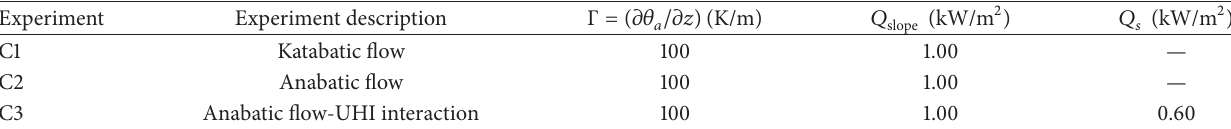
Table 2: Slope flow experimental parameters. Time 𝑡 = 0 corresponds to beginning of image and temperature acquisition; for experiments C1 and C2 heat is provided along the slope from 𝑡 = 20 s; for experiment C3 the UHI heat flux begins at time 𝑡 = 2 s and heat is provided along the slope from 𝑡 = 120 s; in experiments C2 and C3 the bottom is heated from 𝑡 = 2 s from the beginning of the experiments to start and sustain convection. Γ was the vertical component of the temperature gradient; 𝑄 𝑠 was the surplus of surface heat flux due to the UHI; 𝑄 was slope heat flux. The duration of the experiments is roughly 600s. slope